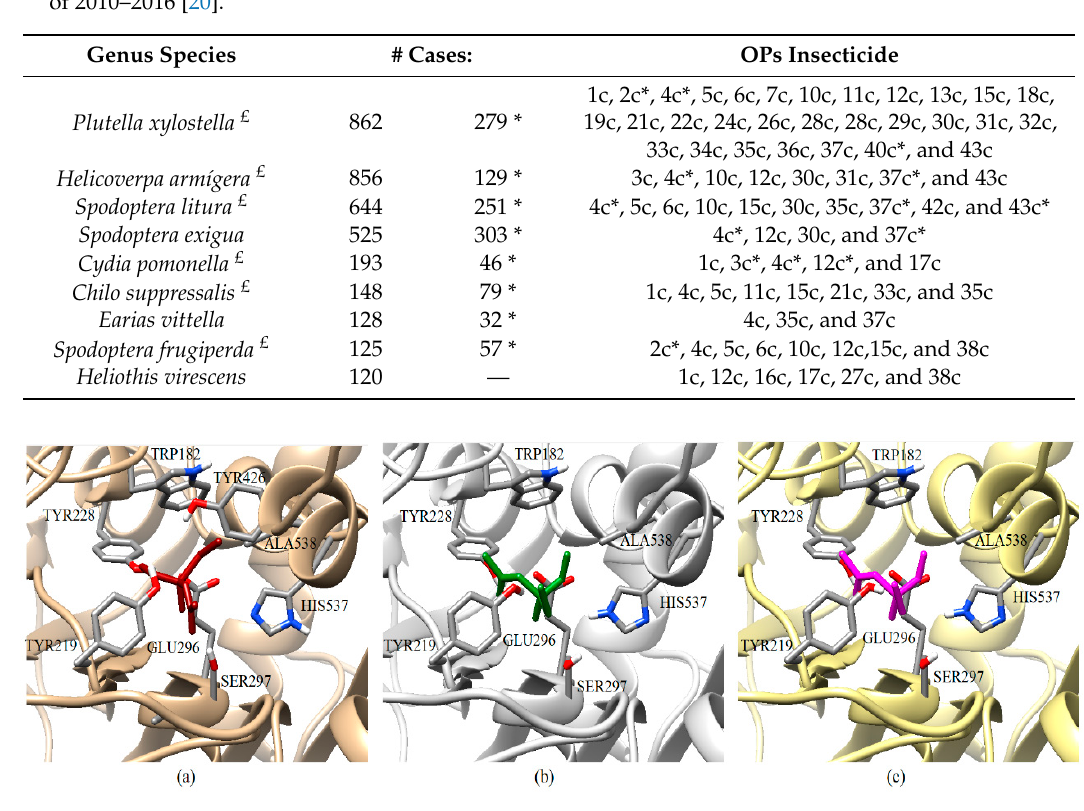
Table 2. Top nine Lepidoptera organisms involved in resistance to OPs. £ Studied in this work * Period of 2010–2016 [20].